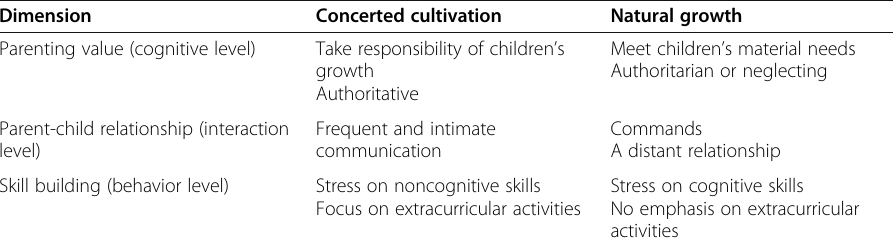
Table 1 Definitions of parenting practice